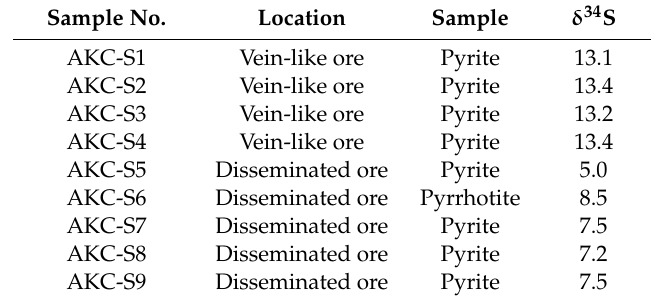
Figure 8. Histogram of S isotopic composition of sulfides from vein-like ore and disseminated ore.